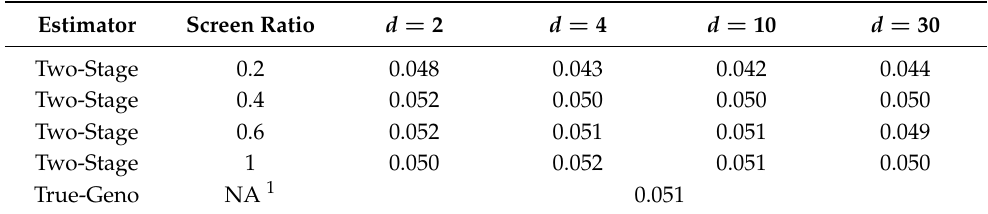
Table 2. Type 1 Errors without Multiple Test Adjustment for Continuous Phenotype with